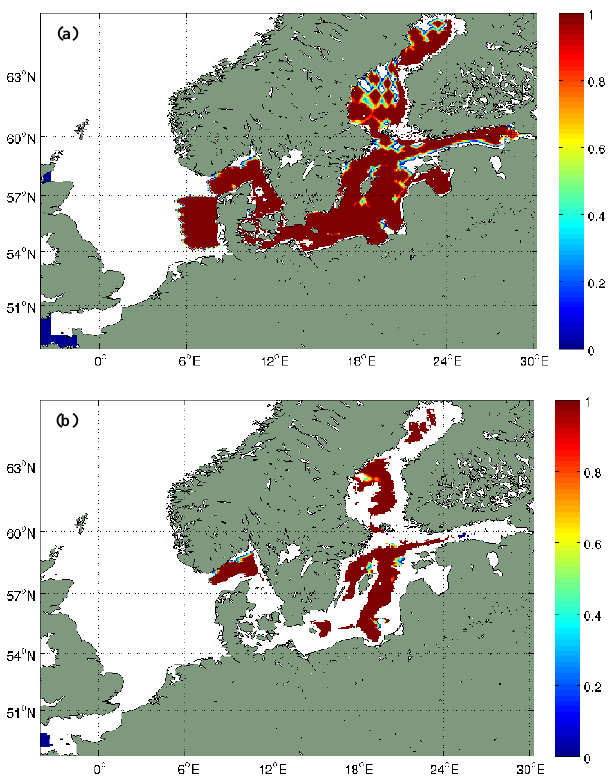
Fig. 10. Effective coverage rate at the depth of (a) 10m and (b) 75m for